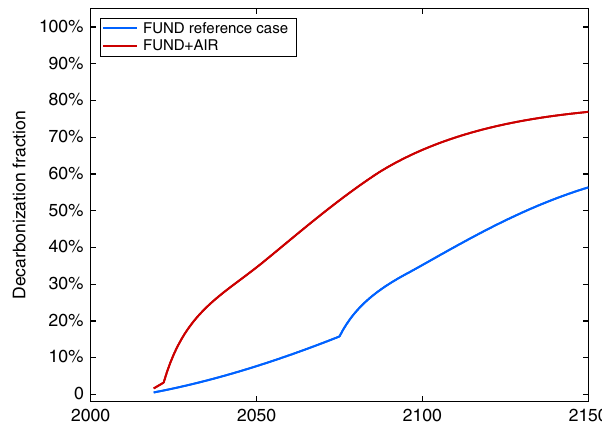
Fig. 6 FUND + AIR results. Optimal decarbonization rates over time for the FUND reference case (that excludes health bene fi ts) and the FUND +